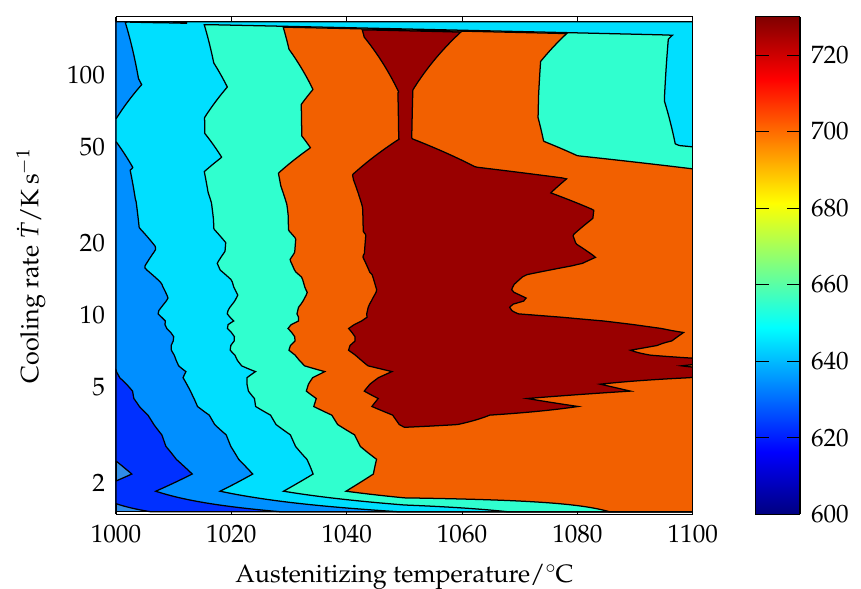
Figure 23. Hardness/HV10 as a function of the cooling rate (logarithmic scale) and the austenitiz- ing temperature.